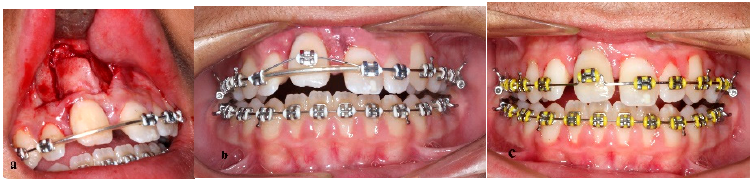
Figure 5. Surgical procedure. ( a ) Subapical osteotomy, ( b ) 0.014 inch NiTi segmented arch wire for vertical distraction, ( c ) ankylosed incisor almost in place.